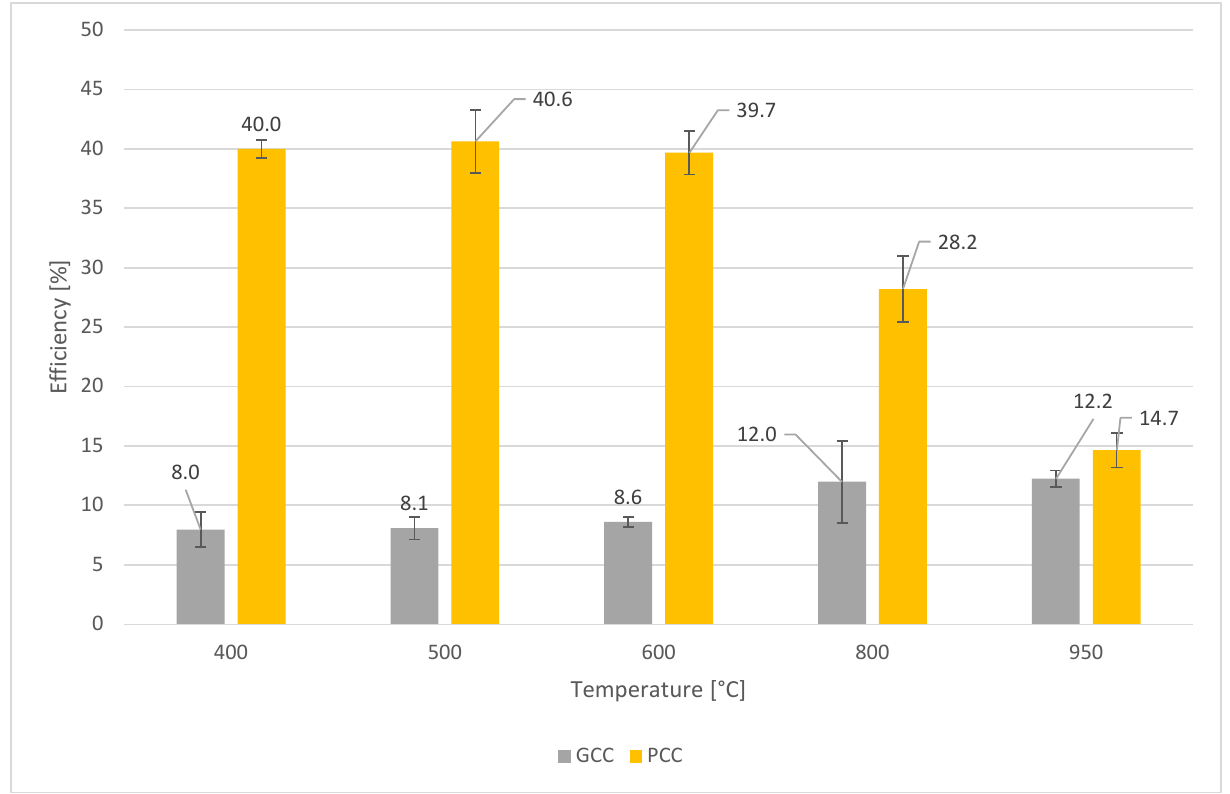
Figure 2. The efficiency % (T) of F50.0 containing 90 phr of GCC (gray), and F50.3, containing 90 phr of PCC (yellow). Standard deviation ranges are reported.